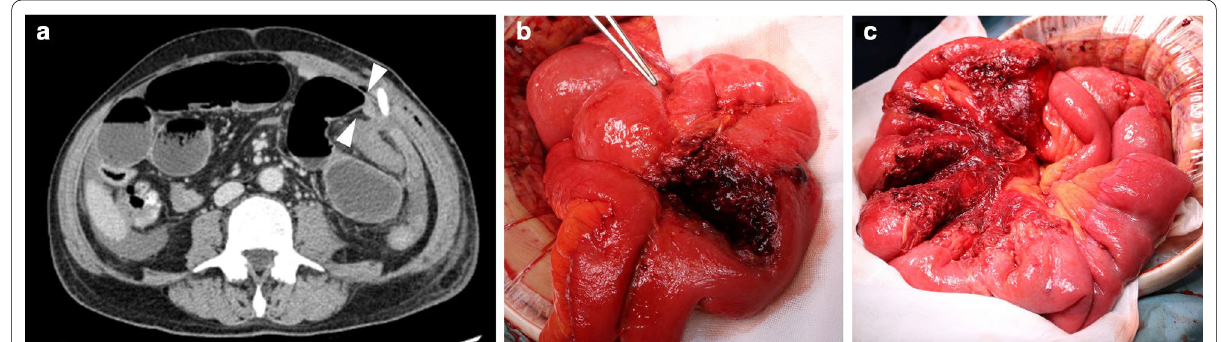
Fig. 4 Computed tomography scan before re-operation and operative finding. Computed tomography revealed intra-abdominal hematoma and caliber changes in the small intestine ( a arrowheads). The small intestine was obstructed by the intra-abdominal hematoma ( b ), and intestinal obstruction was released by removal of the hematoma ( c